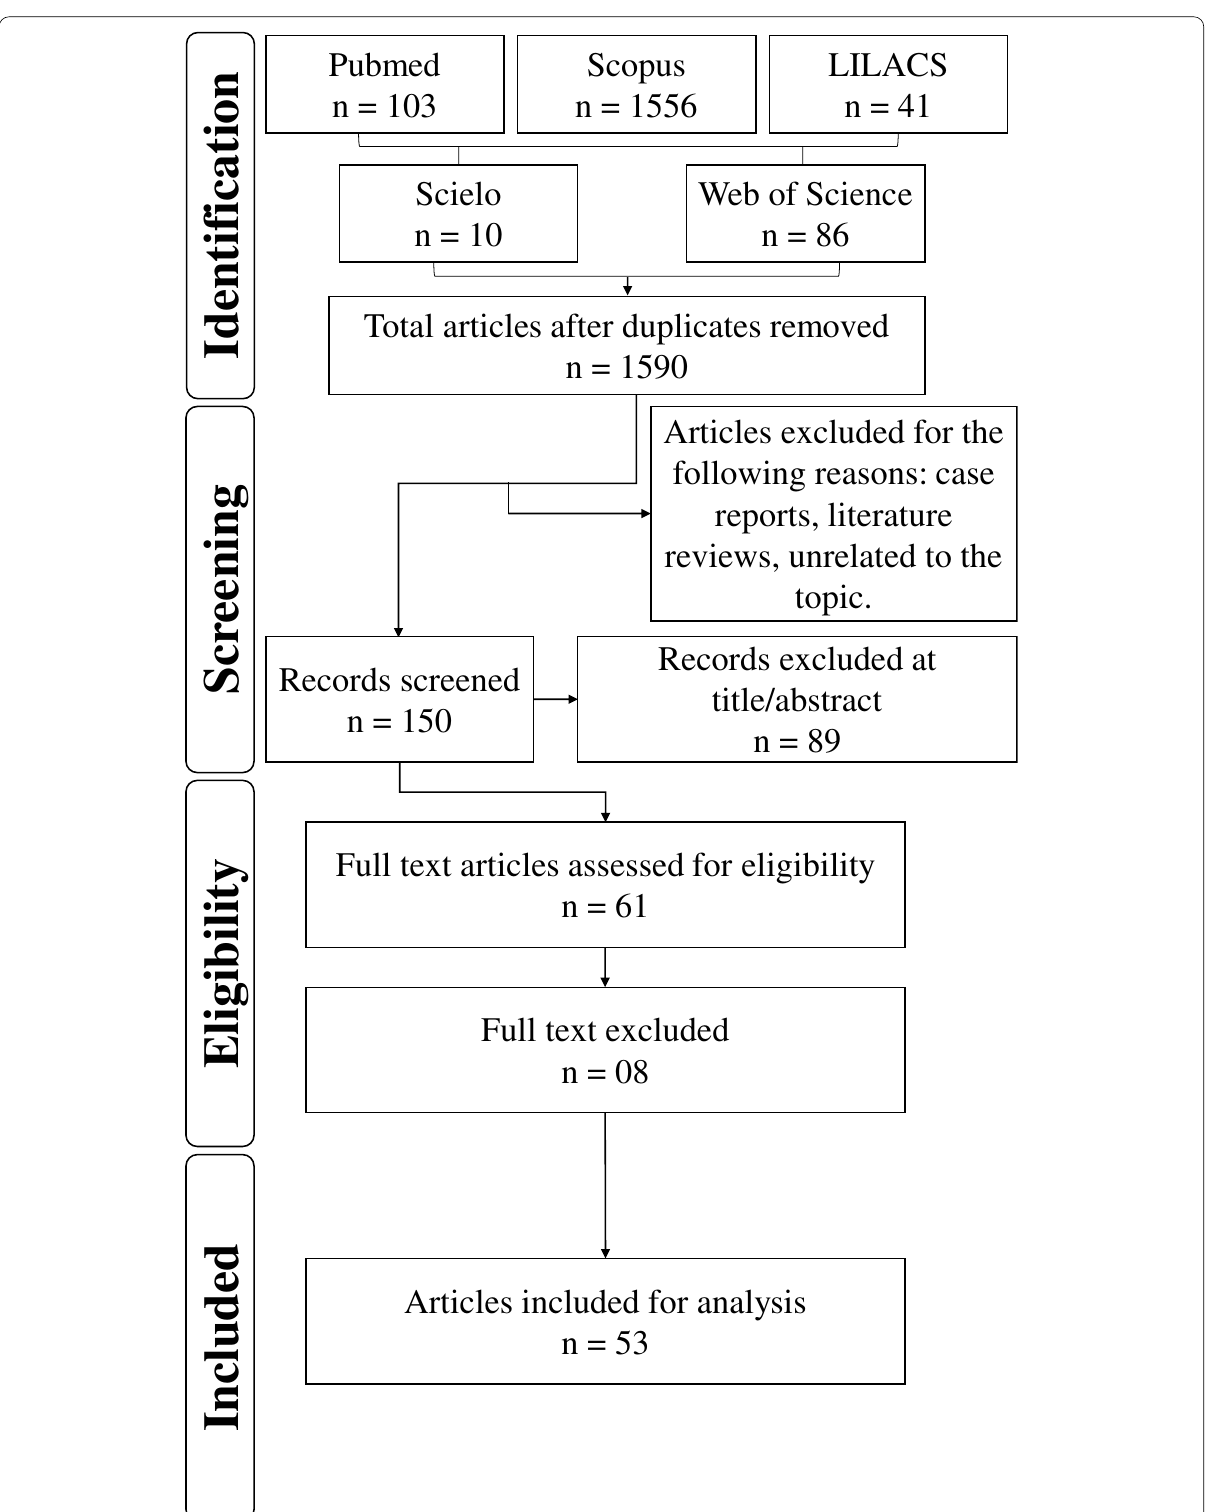
Fig. 1 Flowchart of the search results in the